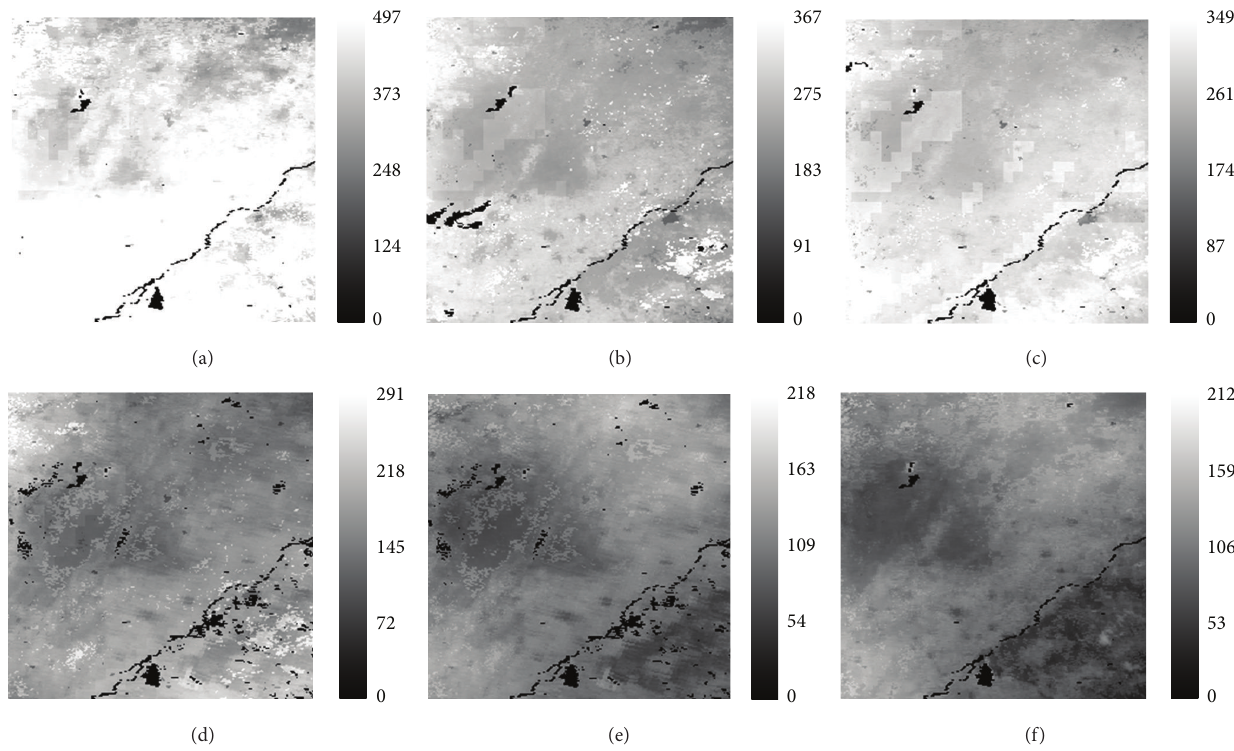
Figure 6: The assimilated EPs from the PEKF method at 15:00 solar time. (a) The assimilated EP on May 2, 2005; (b) the assimilated EP on May 7, 2005; (c) the assimilated EP on May 14, 2005; (d) the assimilated EP on May 19, 2005; (e) the assimilated EP on May 25, 2005; (f) the assimilated EP on May 31,